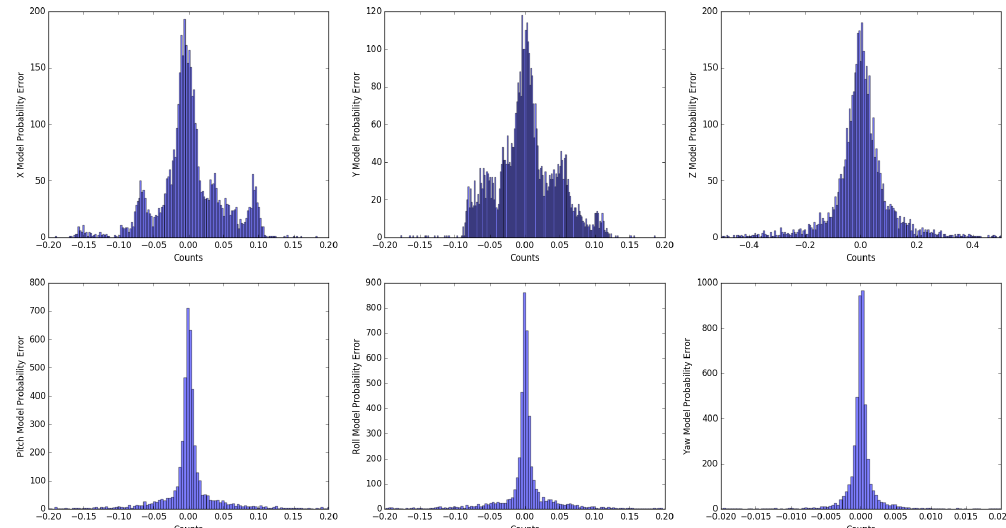
Figure 5. Probabilistic error distribution representation for each vehicle output variable.